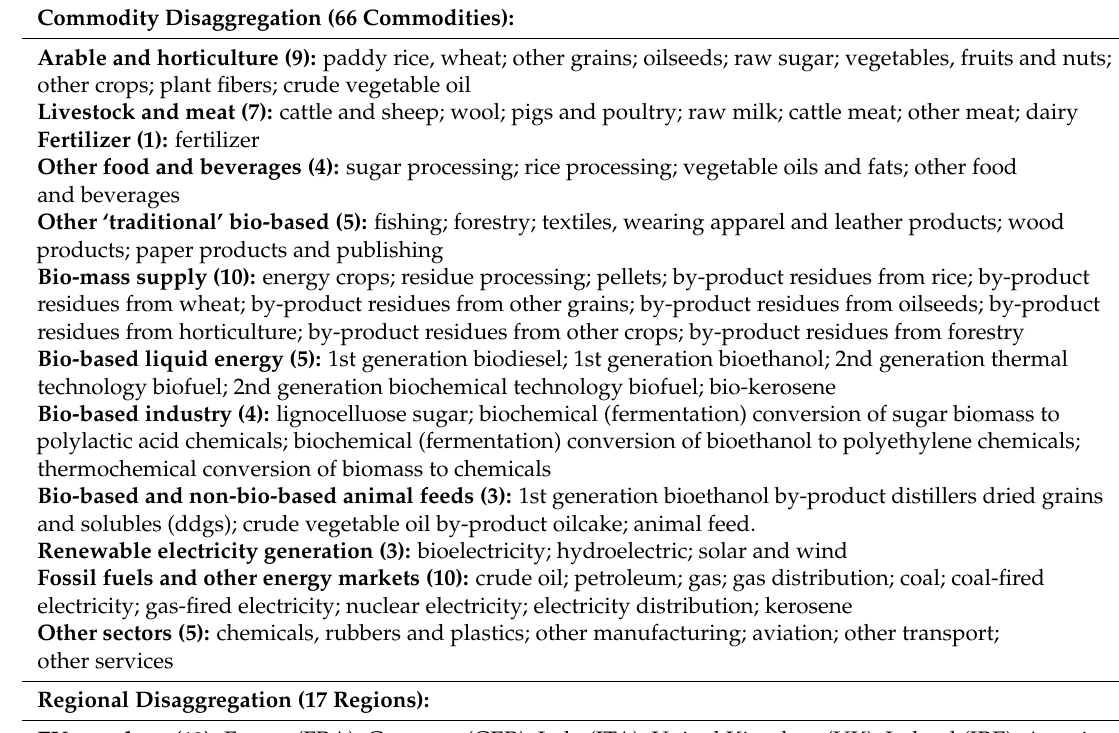
Table 1. Study disaggregation of commodities and